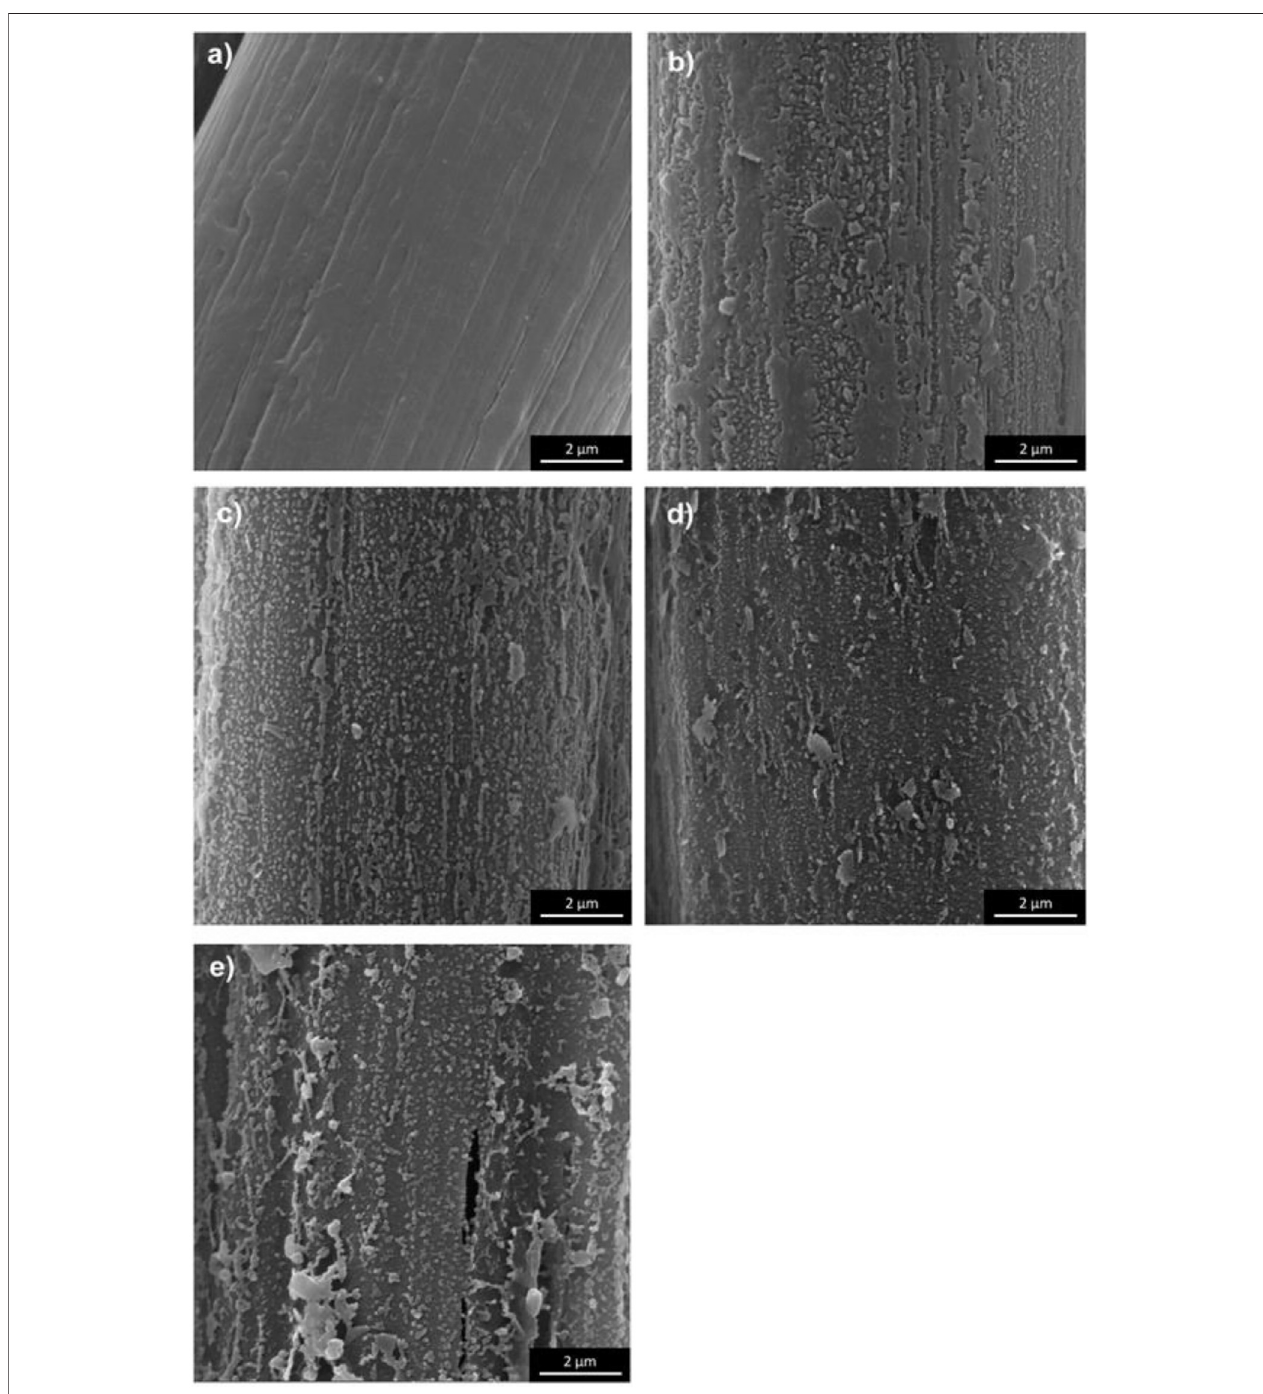
FIGURE3| SEMimagesofthe fi bersurfaceof: (A) reference, (B) 10 min, (C) 30 min, (D) 60 min, (E) 90 minplasma-treatedmeta-aramid(mAr)yarn(magni fi cation × 20,000).